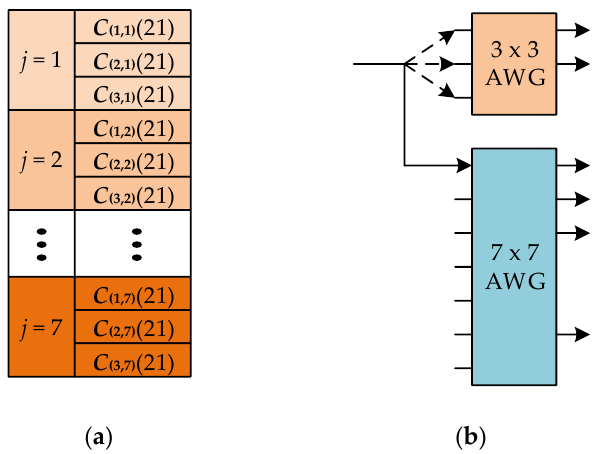
Figure 6. The optical buffering scenario for high quality-of-service (QoS) packets. ( a ) Code partition method; ( b ) encoder setup.